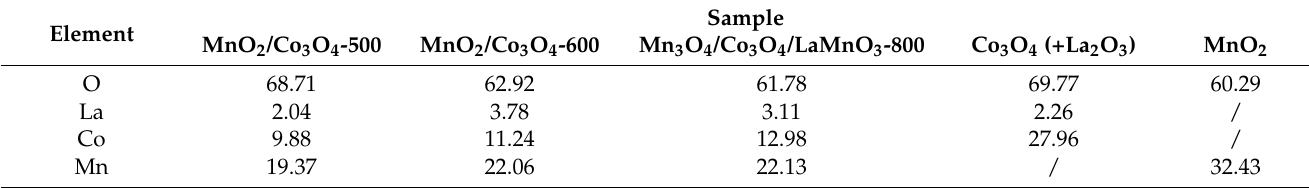
Figure 3. SEM images of ( a , b ) Mn 3 O 4 /Co 3 O 4 -800 and ( c , d ) Co 3 O 4 /La 2 O 3 ; at lower and higher mag- Figure 3. SEMimagesof( a , b )Mn 3 O 4 /Co 3 O 4 -800and( c , d )Co 3 O 4 /La 2 O 3 ;atlowerandhighermagnifications. nifications. Table 1. Element analysis of synthesized materials for EDS analysis (at. Table 1. Element analysis of synthesized materials for EDS analysis (at. %).